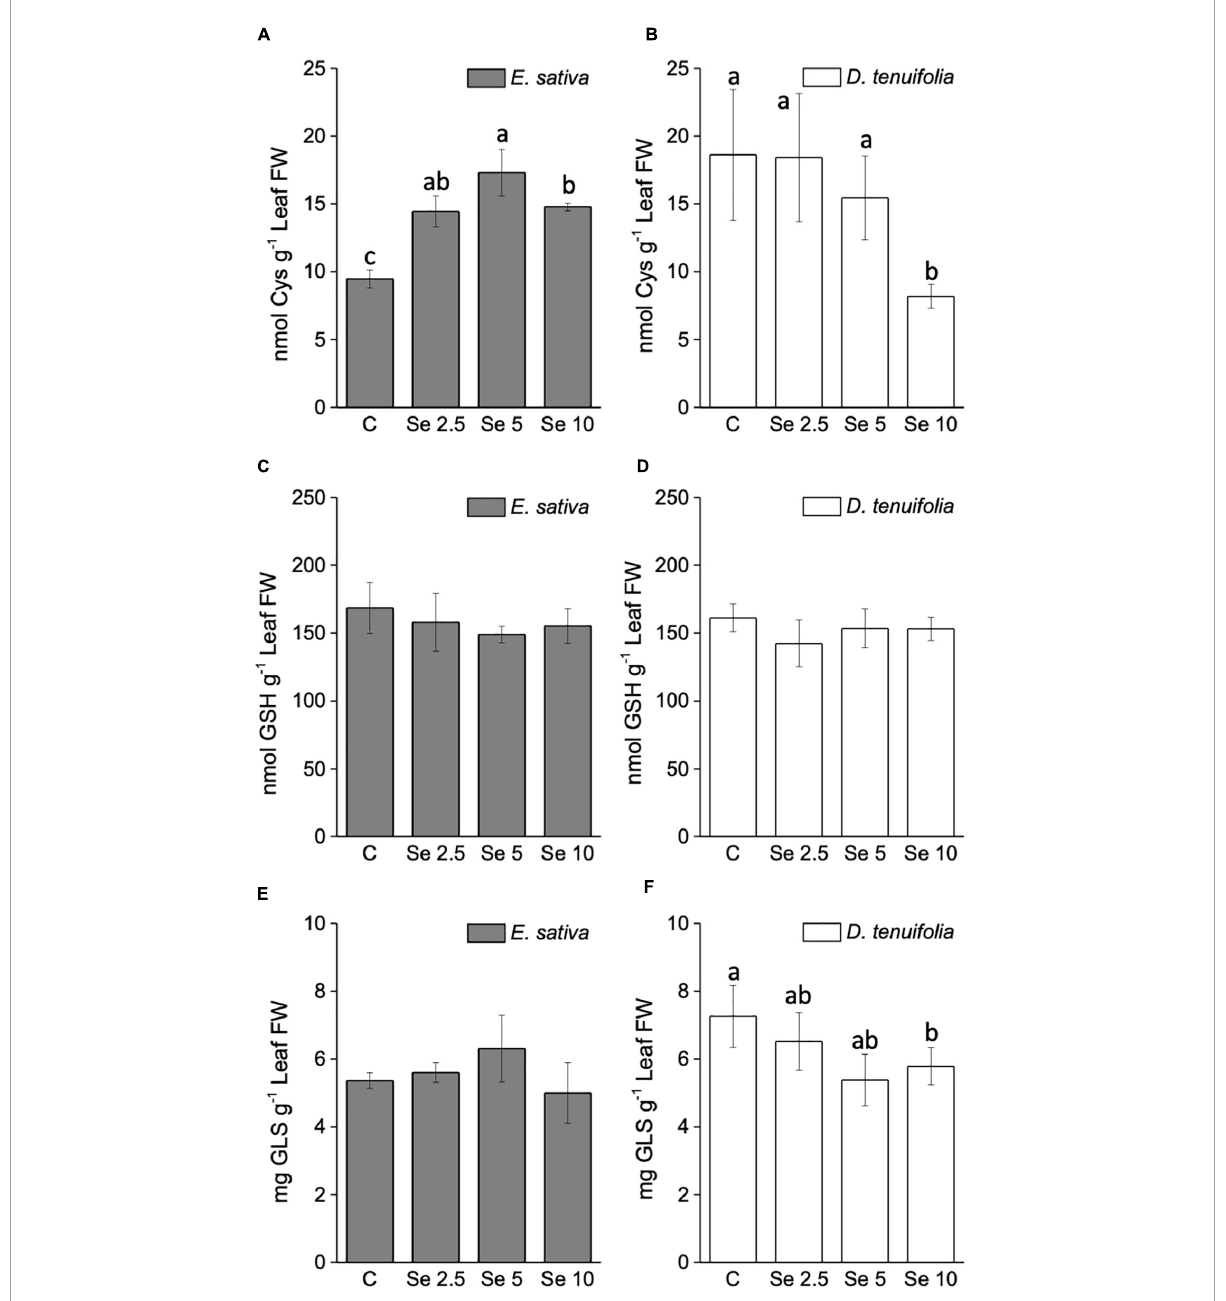
FIGURE4 Content of cysteine (A,B) , total glutathione (C,D) and total glucosinolates (E,F) in leaves of E. sativa and D. tenuifolia plants grown in soil and subjected to foliar fertilization with selenate dosages ranging from 0 to 10 mg per plant. Data shown are the mean ± SD of three replicates. Different letters above bars indicate significant differences between the means ( p <